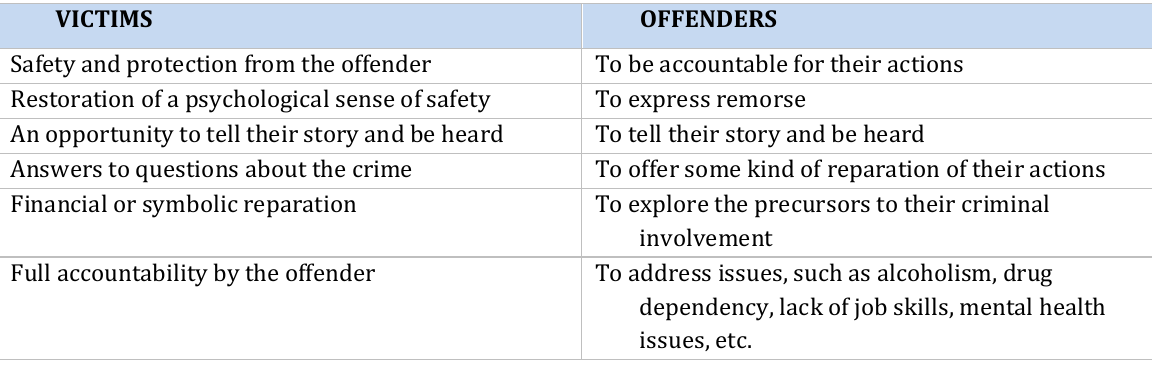
Table 1. Identified Needs and Obligations of Victims and Offenders